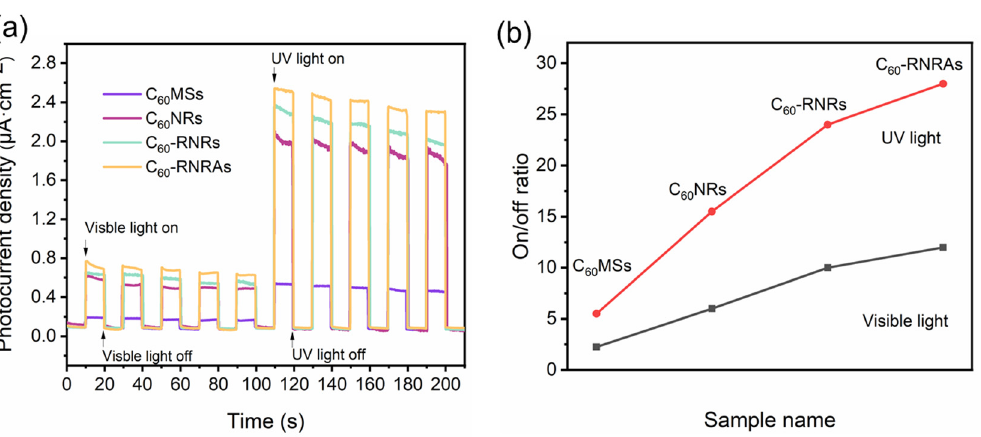
Figure 7. ( a ) Typical photocurrent response curves and ( b ) on-off ratios of C 60 MSs , C 60 NRs , and C 60 -RNRAs under visible light (400–760 nm) or UV light (350 nm) irradiation. Conditions: 0.1 M KCl aqueous solution at 1 V bias voltage.